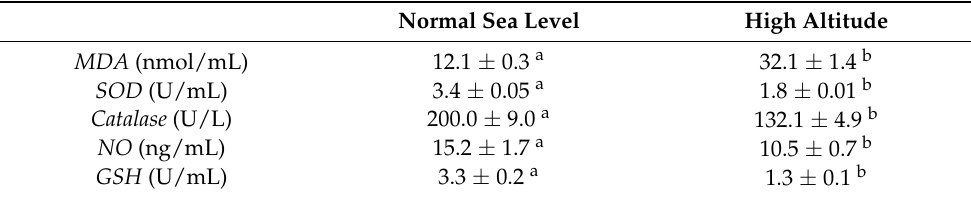
Table 3. Alterations in serum MDA, catalase, SOD, NO, and GSH levels between groups living at normal sea level and at high